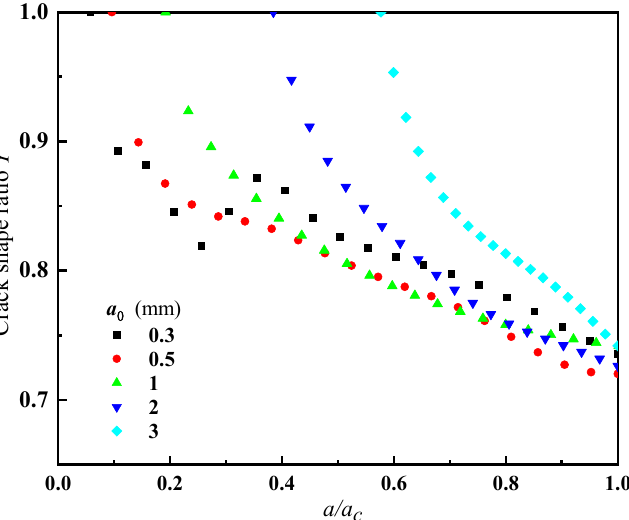
Figure 10. The shape evolution of a semi-elliptical surface crack growth with different initial sizes.